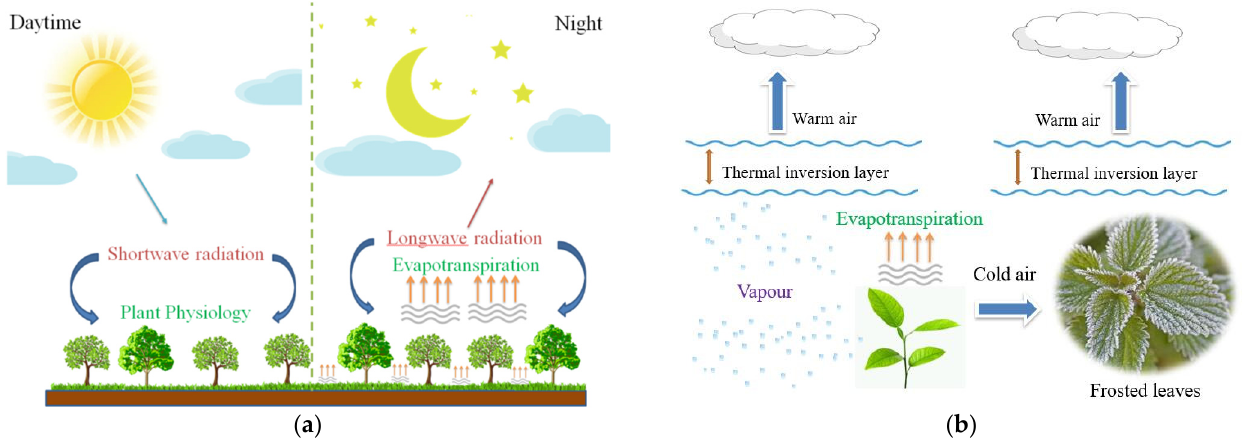
Figure 1. Schematic diagram of plant surface frosting under natural radiation conditions: ( a ) natural radiation frost formation conditions; ( b ) principle frost formation on plant surface.